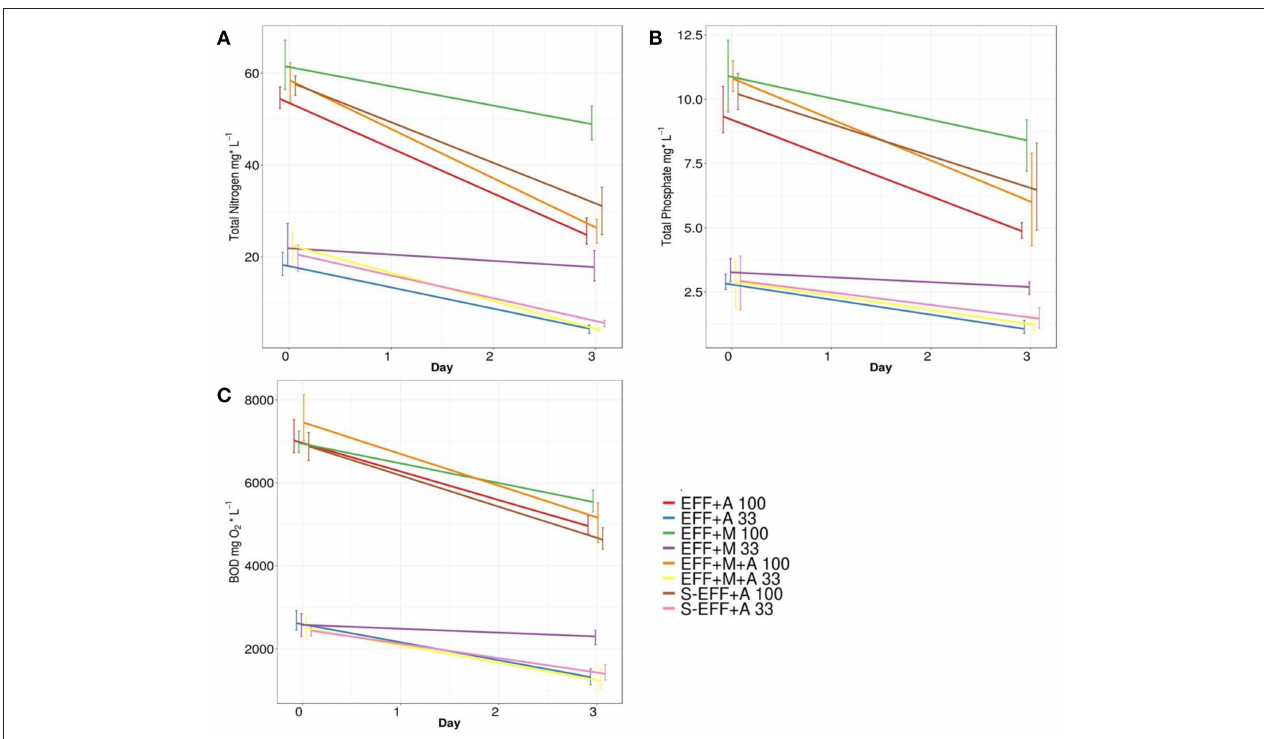
FIGURE 3 | Substrate degradation rates as a function of total N (A) , total P (B) , and BOD values (C) . Measurements were done at the start and at the end (72h) of the photoheterotrophic degradation experiments. The photoheterotrophic degradation measurements were performed on diluted and non-diluted dark fermentation effluents (33 and 100% concentrations,